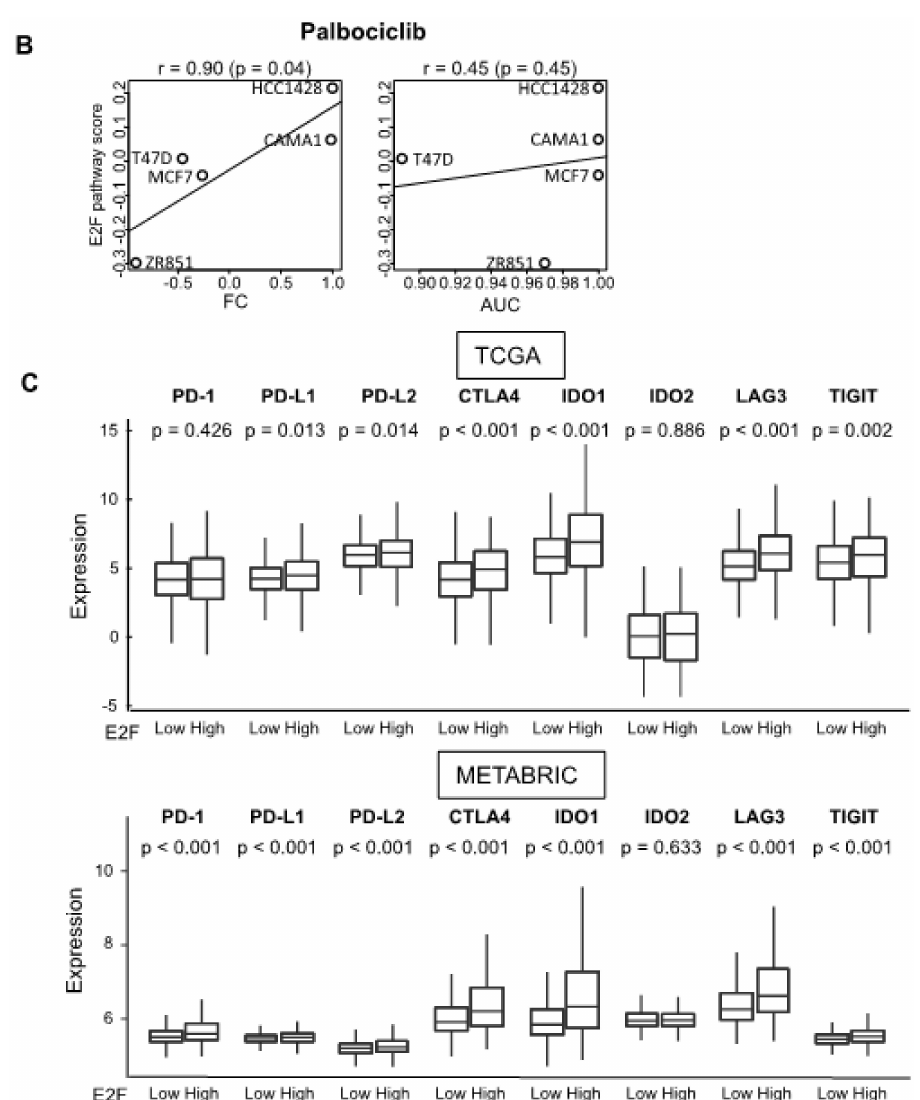
Figure 6. Relationships between targeted therapy and the E2F pathway score. ( A ) Boxplots depict tumor gene expression (log 2 transcripts per million) of cyclin-dependent kinase ( CDK ) pathway-related genes of tumors with low and high E2F scores among the TCGA and METABRIC cohorts. ( B ) Association in human breast cancer cell lines between E2F score and sensitivity to CDK inhibitors. Sensitivity to palbociclib measured in fold change ( FC ) or area under curve ( AUC ) units is plotted against the E2F score of five cell lines (GSE36139 study). Spearman correlation statistics are depicted. ( C ) Tumor gene expression (log 2 transcripts per million) of T cell exhaustion markers in the high and low E2F score groups of the TCGA and METABRIC cohorts. The median value of the E2F score is used to classify tumors into low and high groups. Tukey-type boxplots demonstrate median and inter-quartile level values, and p values were calculated by the ANOVA test. CCNE1 , cyclin E1; CDKN2A , CDK inhibitor 2A; CDKN2D , CDK inhibitor 2D; CTLA4 , cytotoxic T-lymphocyte-associated protein 4; IDO1 / 2 , indoleamine dioxygenase 1 / 2; LAG3 , lymphocyte activation gene 3; PD-1 , programmed death-1; PD-L1 , programmed death ligand 1; TIGIT , tyrosine-based inhibitory motif